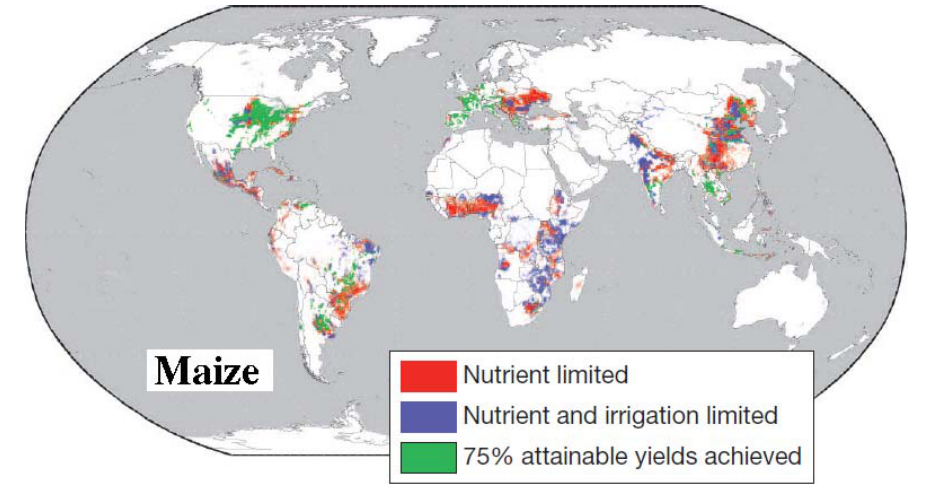
Figure 6. Management factors limiting yield-gap closure to 75% of attainable yields for maize